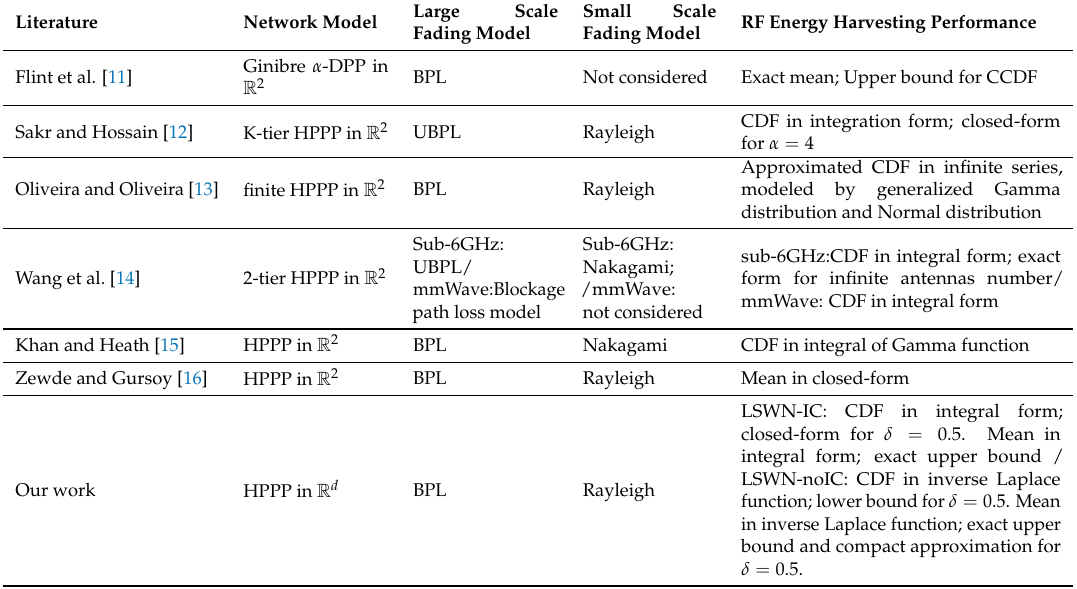
Table 1. Comparison of related